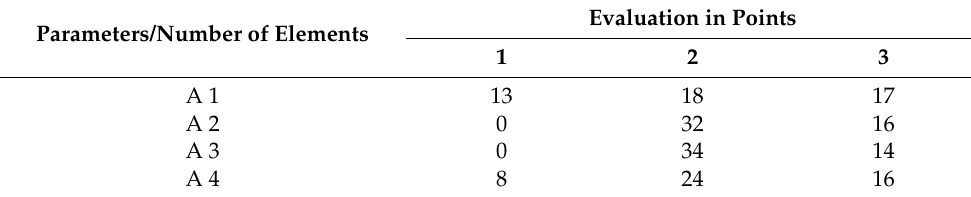
Table 5. Evaluation of windbreaks